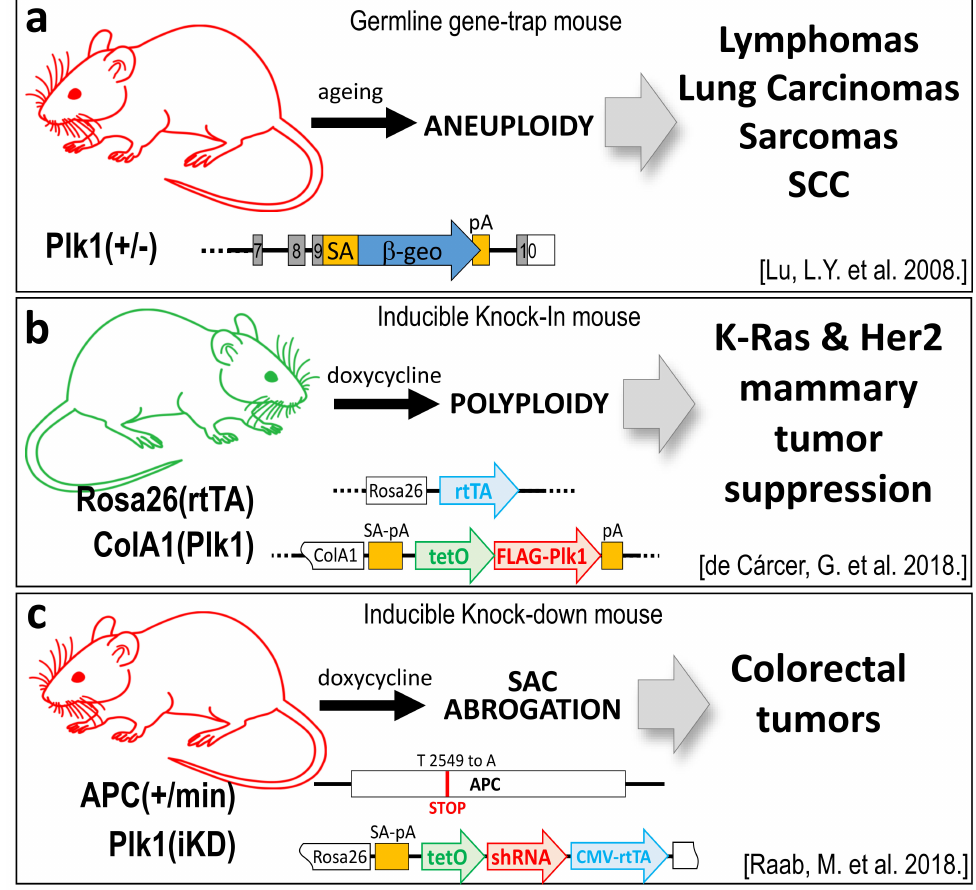
Figure 2. Plk1 genetic mouse models with tumor suppressor properties. ( a ) A germline heterozygous Plk1 mouse ( Plk1+/ − ), generated by gene-trapping the exon 9 of the murine Plk1 gene, develops mainly lymphomas in the long latency, due to aneuploidy. ( b ) Inducible Plk1 knock-in (Plk1-KI), generated by inserting the human Plk1 cDNA down-stream of the tetO sequences in the endogenous ColA1 locus, and later combined with the Rosa26-rtTA transactivator. Plk1 overexpression leads to polyploidy and this stops mammary tumor generation by the Ras and her2 oncogenes. ( c ) Plk1 inducible know-down mouse ( Plk1 -KD) is generated by inserting an shRNA under the tetO promoter u the Rosa26 locus. When combined with the colorectal model APC min mice strain, downregulation of Plk1 leads to an increase in colorectal papillomas due to Spindle Assembly Checkpoint (SAC) abrogation and chromosome instability (CIN) induction. (Plk1 loss of function models are represented in red colored mice. The Plk1 gain of function model is represented by a green